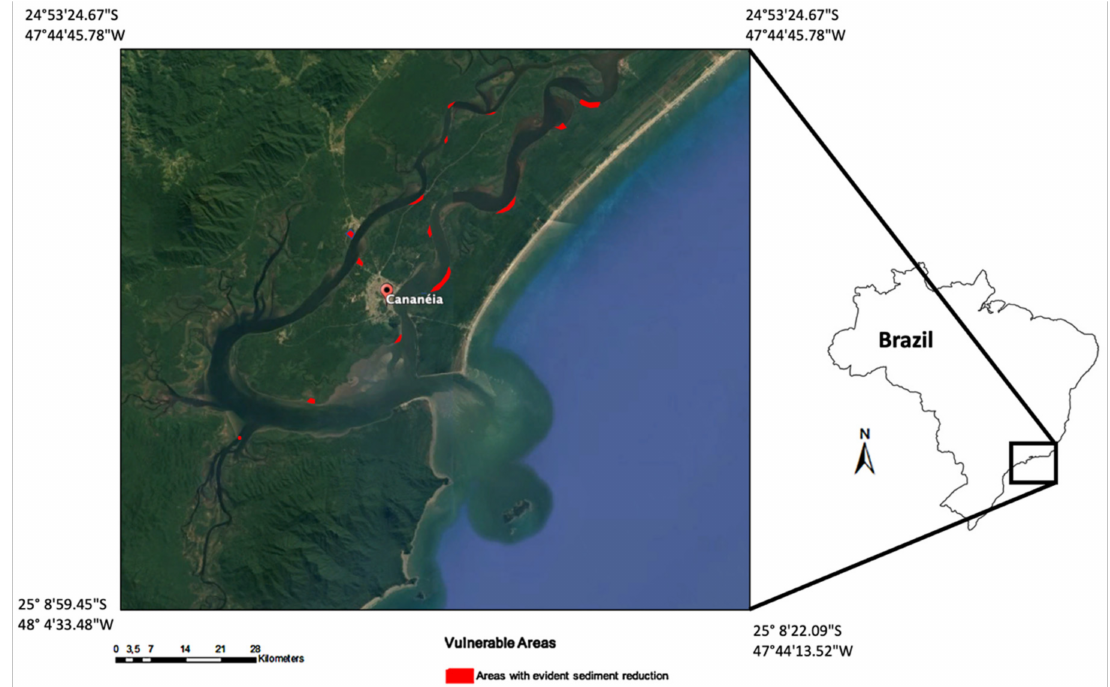
Figure 1. Location of the study area, the estuarine system of Cananeia-Iguape at the extreme south of S ã o Paulo coast, Brazil. The areas vulnerable to erosion are